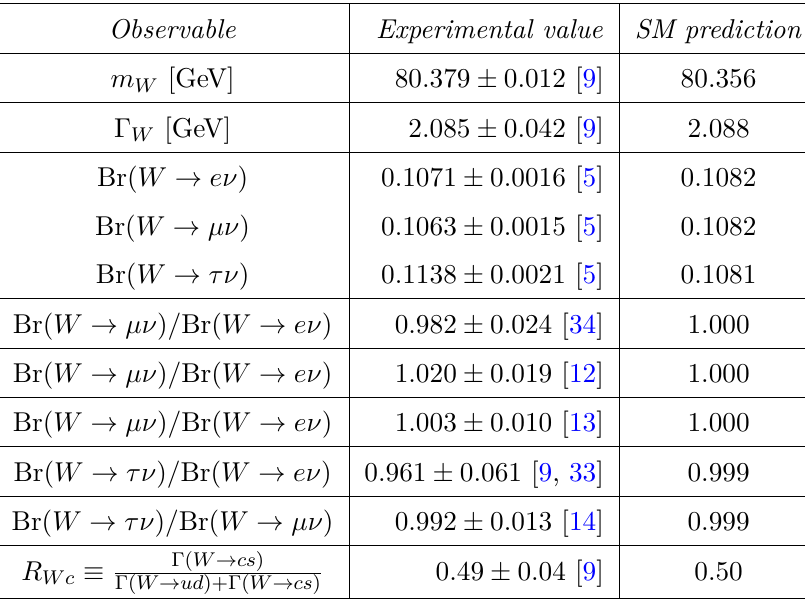
Table 2 . W pole observables . The experimental errors of the observables not separated by hori- zontal lines are correlated, which is taken into account in the